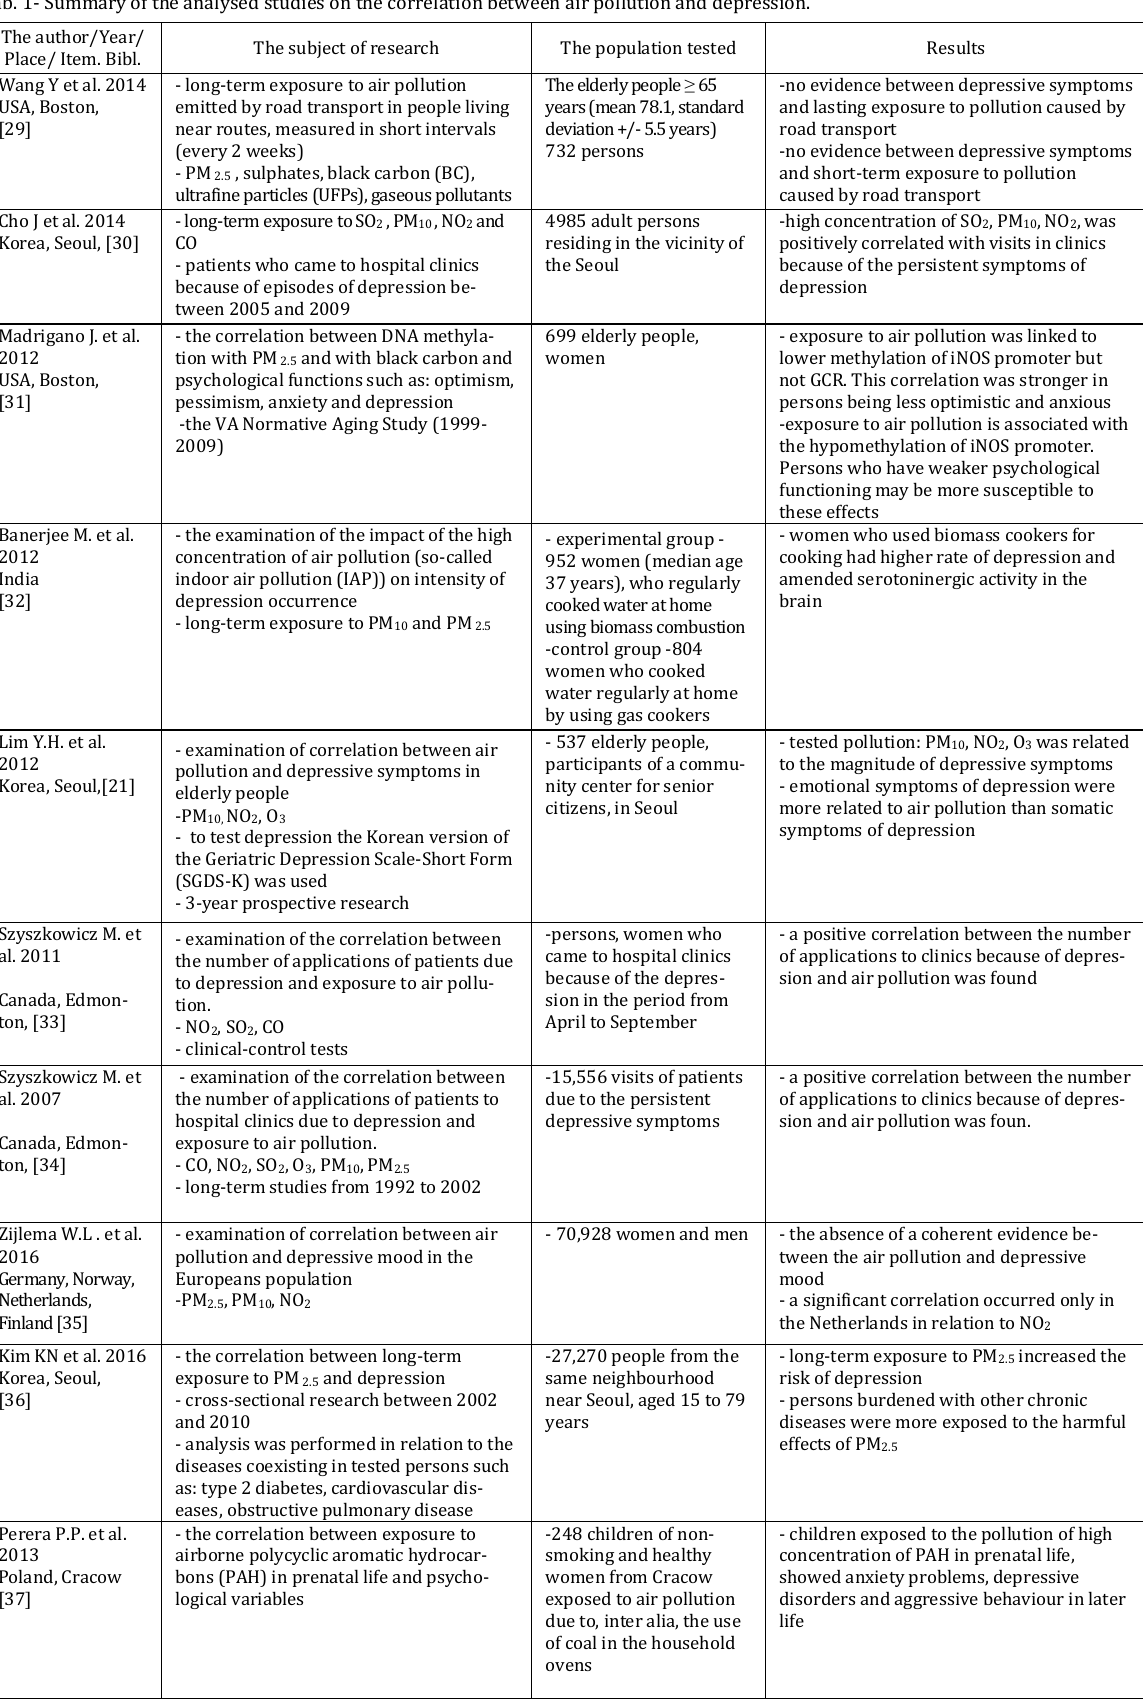
Tab. 1- Summary of the analysed studies on the correlation between air pollution and depression. The author/Year/ Place/ Item.